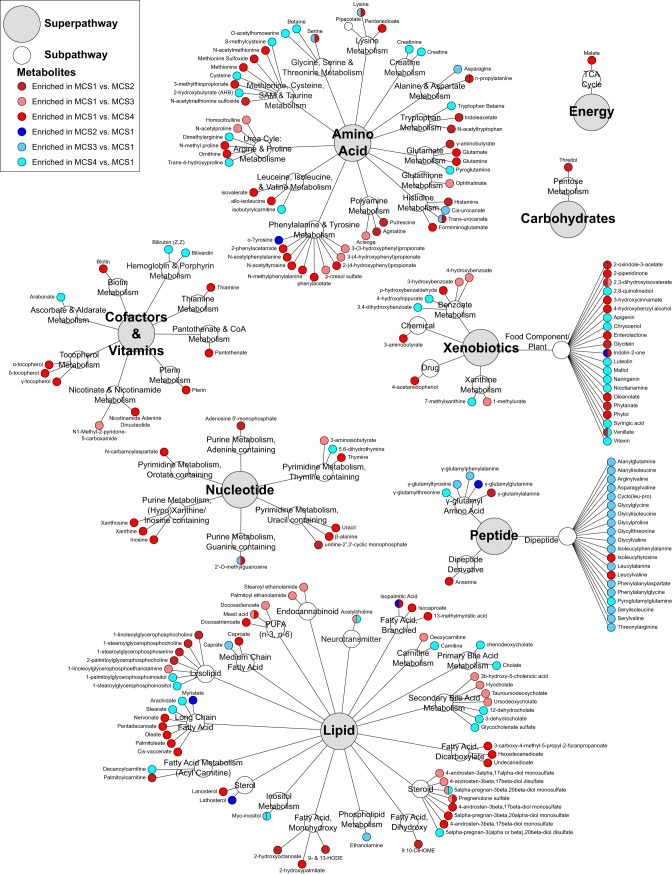
Fecal metabolites significantly differentially enriched among UC patients classified as MCS1, MCS2, MCS3, or MCS4 on the basis of pairwise Welch t tests (P value, <0.05).